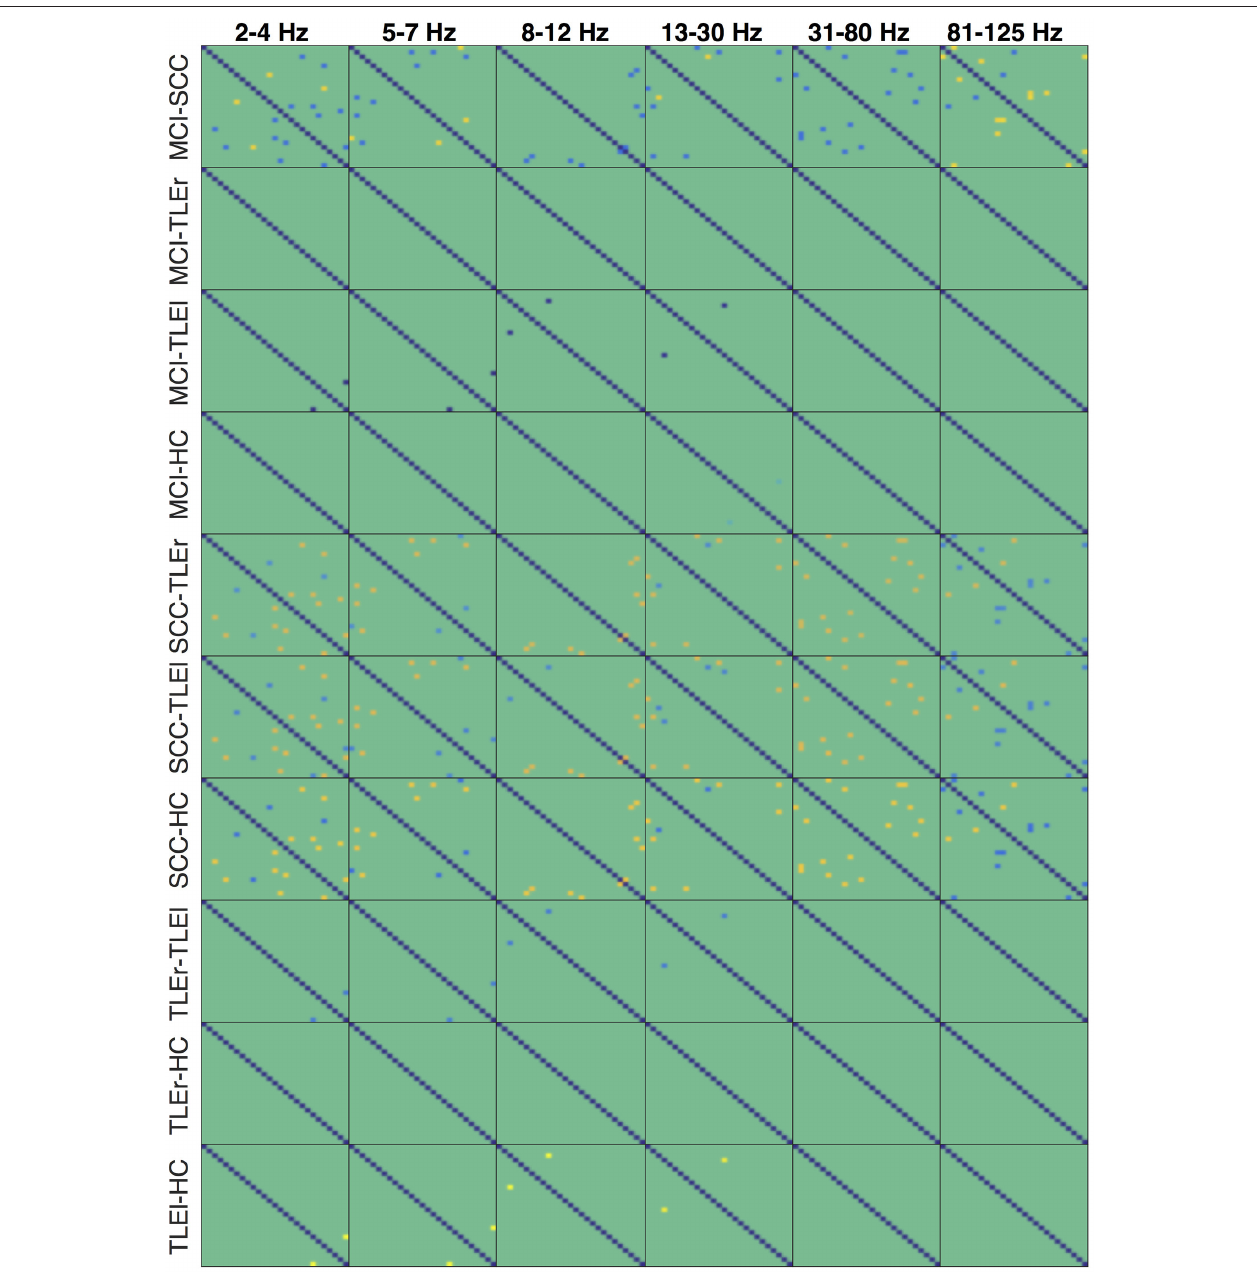
FIGURE 8 | Heatmaps of the group differences in reliability for real valued coherence. Heatmaps show the reliability of all electrode × electrode interactions for measure of interaction real valued coherence, sorted by group comparisons in rows and frequency in columns. Each of the small boxes is drawn as the network matrix with one point corresponding to a specific electrode × electrode combination. Colors indicate values from − 37.45 (dark blue) to + 32.85 (bright yellow). Not-significant differences were set to 0 and appear in green. Electrodes start from top left following the order of the list as given in Section 2.4. MCI, mild cognitive impairment; SCC, subjective cognitive complaints; TLEr, right lateralized temporal lobe epilepsy; TLEl, left lateralized temporal lobe epilepsy; HC, healthy controls.